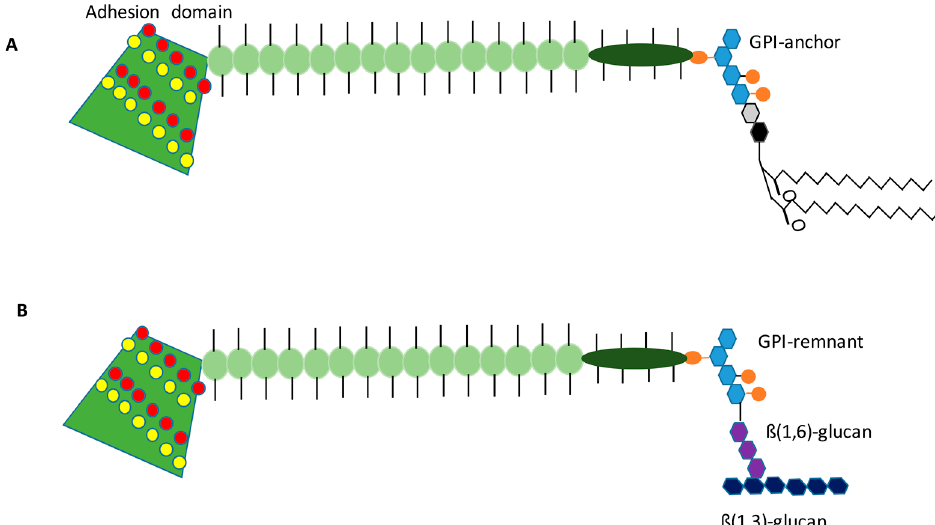
Figure 3. Flo11 appears to be a GPI-anchored protein with bands of hydrophobic residues in the N- terminal adhesion domain. The predicted Flo11 structure is shown in cartoon form, but lacking the N-terminal signal sequence, as it may be cleaved in the mature protein during translocation into the endoplasmic reticulum ( ER). The N-terminal adhesion domain is wedge shaped and has two bands of hydrophobic, aromatic residues (yellow dots) as well as two bands of acidic residues (red dots). The serine-threonine-rich repeat regions in the stock are shown as light green balls with sticks representing predicted glycosylation. The dark green area proceeds the C-terminal GPI-anchor signal. ( A ) The membrane bound form of the protein with the full GPI-anchor is depicted. ( B ) The cell wall form of Flo11, bound by the GPI-remnant to the cell wall carbohydrates is depicted. Hexagons: The hexagons represent sugars in the GPI-anchor or cell wall. Light blue—mannose, Grey— N -glucosamine, Black—inositol, Purple— β (1,6)-glucan, Deep blue— β (1,3)-glucan. The orange circles on the GPI-anchor represent phosphoethanolamine groups.